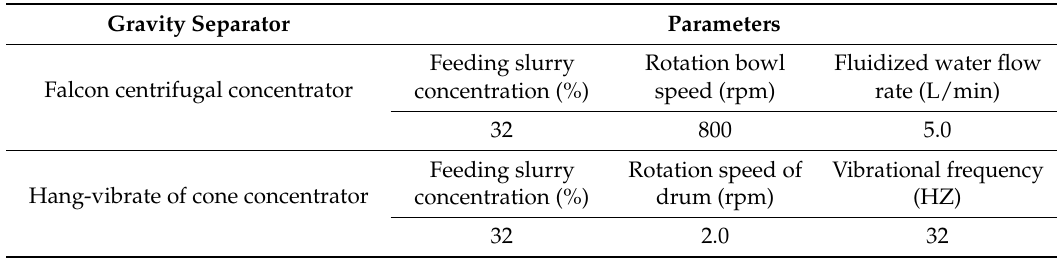
Table 2. The optimized parameters for the gravity